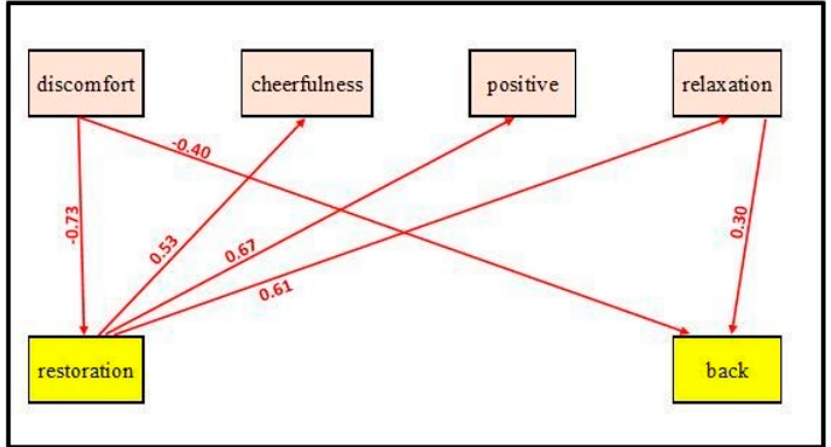
Figure 3. An AMOS SPSS path model of cognitive vs. emotional indices of coping with Environ- ments.